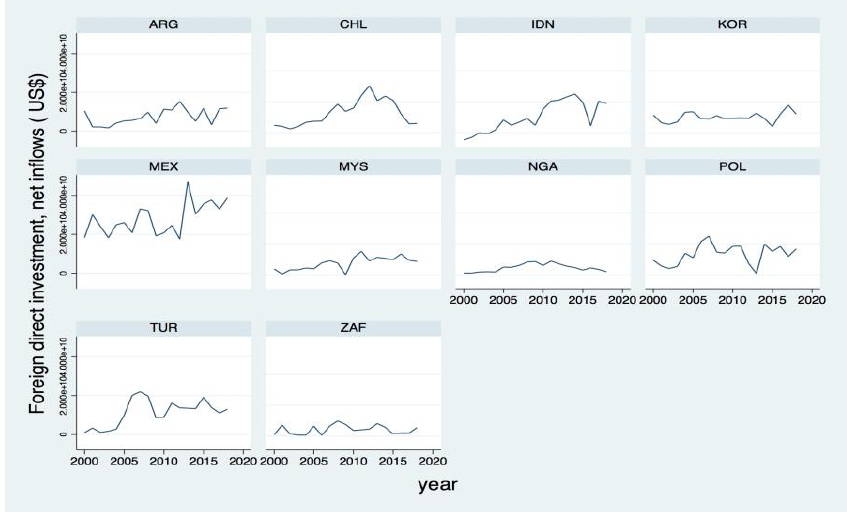
Figure 2: FDI Inflows by Emerging